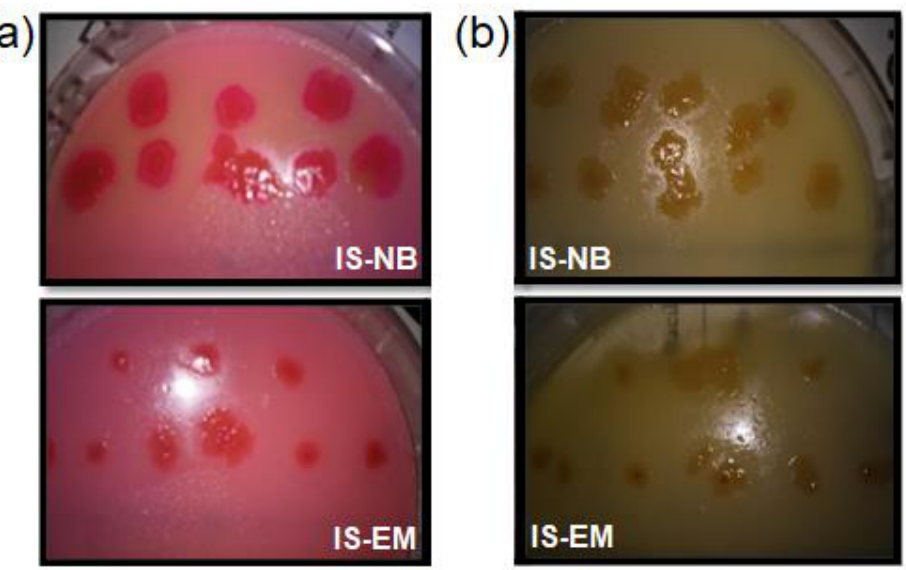
Figure 6. Colony formation of strains isolated from El Chichón volcano crater lake. ( a ) Geobacillus jurassicus CHI 2 ; ( b ) Geobacillus stearothermophilus CHI 1 ; IS-NB and IS-EM—initial seeding of microorganisms cultivated in NB and EM, respectively.